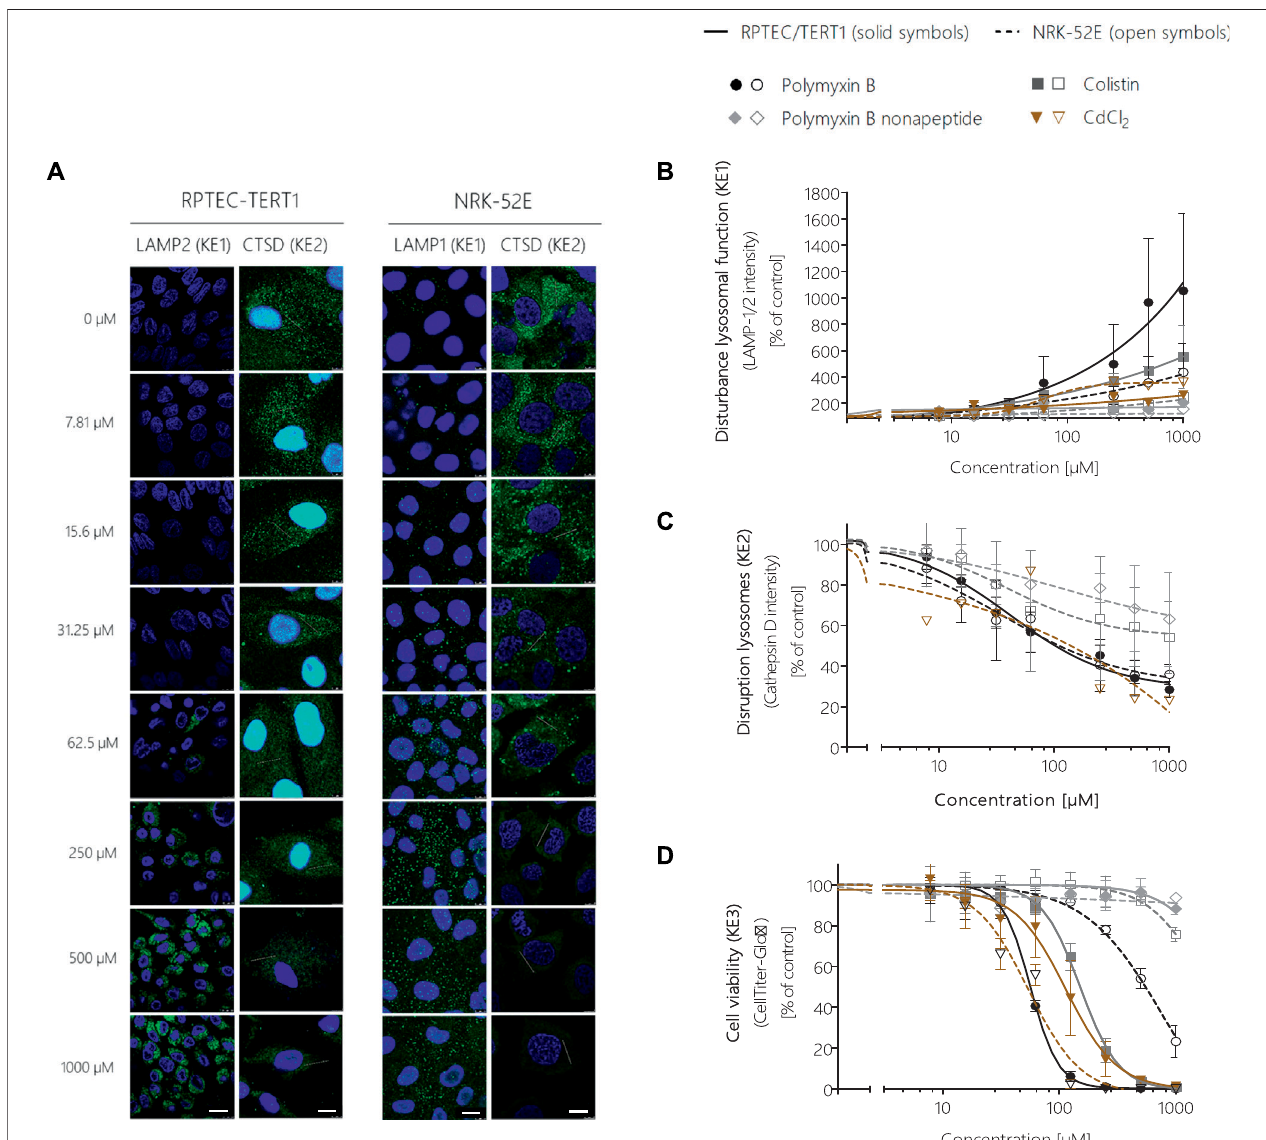
FIGURE 5 | Quantitative analysis of the effect of polymyxin B across the KEs of the AOP receptor-mediated endocytosis and lysosomal overload. Confocal immuno fl uorescence images of LAMP-1/2 (green; scale bar: 15 µm) and cathepsin D (green, scale bar: 10 µm) in RPTEC/TERT1 and NRK-52E cells treated with polymyxin B for 24 h (A) . Cell nuclei were stained with DAPI (blue). Untreated kidney tubule cells showed poor LAMP-1/2 staining, while treatment with polymyxin B resulted in a concentration-dependent increase in LAMP-1/2 (A,B) . Cathepsin D staining in untreated cells appeared with characteristic punctual structures throughout the cytosol, consistent with its lysosomal localization. Treatment with polymyxin B caused a concentration-dependent re-distribution of the punctate cathepsin D staining to a more diffuse staining throughout the cytosol, indicative for lysosomal membrane permeabilization with release of cathepsin D (A,C) . Concentration-responsecurvesobtainedfromLAMP-1/2(KE1)andcathepsinD(KE1)immuno fl uorescenceanalysis (B,C) andcellviability(KE3) (D) followingtreatment ofRPTEC/TERT1(solidlines,solidsymbols)andNRK-52Ecells(dashedlines,opensymbols)withpolymyxinB,colistin,polymyxinBnonapeptide andCdCl 2 asputative stressors for this AOP. Note that technical issues precluded generation of cathepsin D data on colistin, PBNP, and CdCl 2 in RPTEC/TERT1 cells (C) . All experiments were performed in three independent experiments carried out in triplicates. Data are presented as mean ± SD fold change ( n = 3).